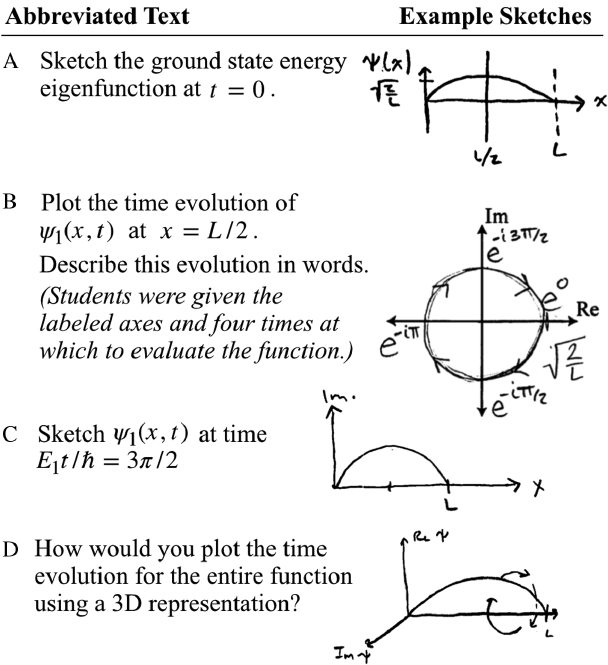
FIG. 3. Abbreviated versions of tasks A, B, C, and D of the time development of infinite well quantum states activity and sample student sketches. They are a subset of the tasks that are asked of students prior to working with the simulation (see Supplemental Material [73] for the full activity). The roles of sketching in these tasks are to activate prior knowledge (task A), to transform across representations (tasks B and C), and to invent representations (task